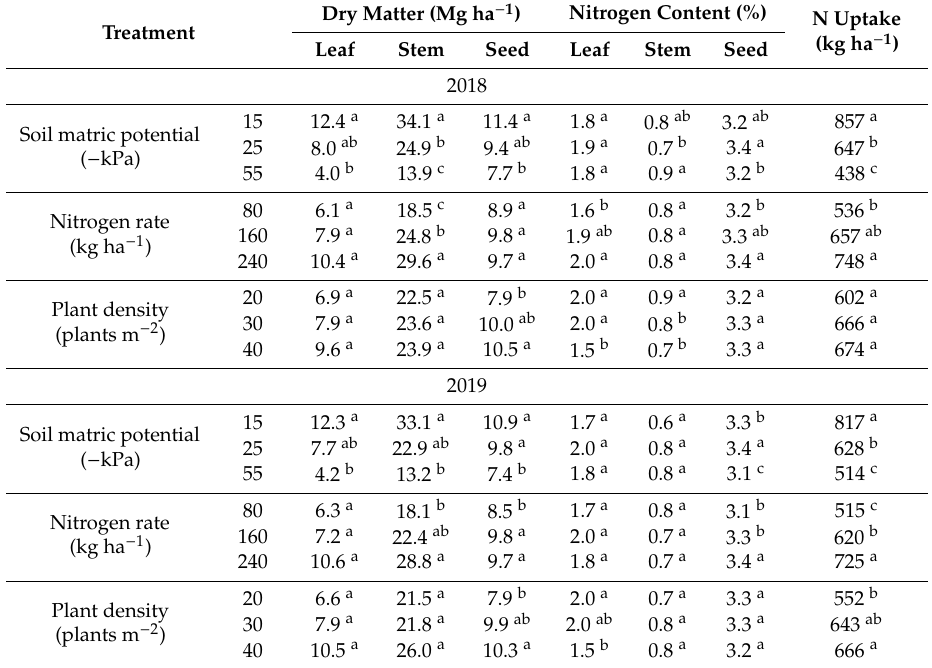
Table 7. E ff ects of soil matric potential, nitrogen application rate, and plant density on the dry matter (Mg ha − 1 ) and nitrogen content (%) of leaf, stem, and seed, and nitrogen uptake (kg ha − 1 ) in 2018 and